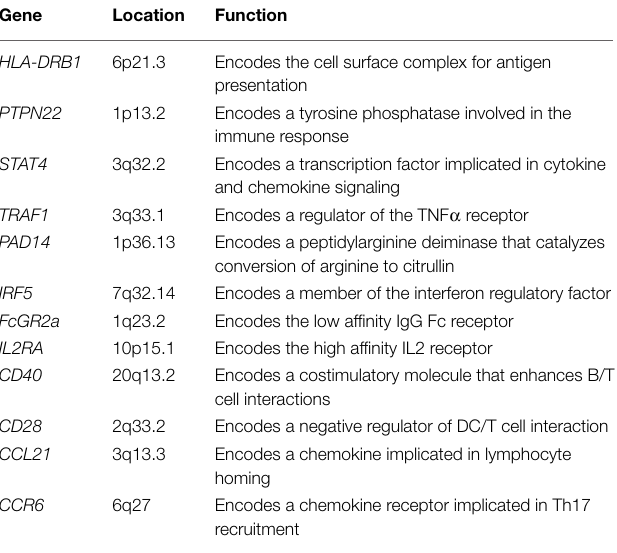
TABLE 1 | Most relevant genes with single-nucleotide polymorphisms associated with susceptibility to rheumatoid arthritis and their functional role